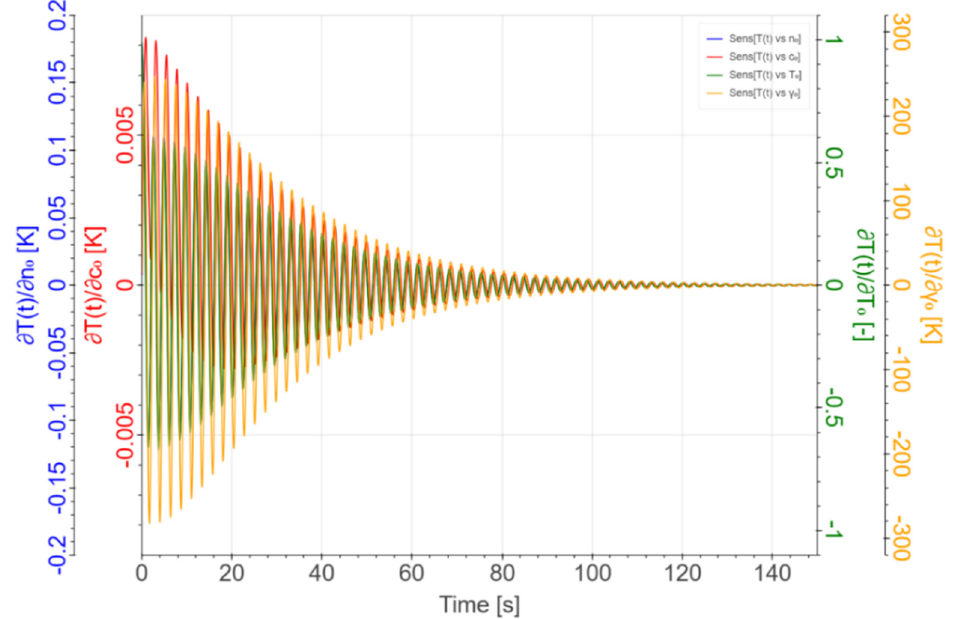
( ) T t with respect to the initial conditions